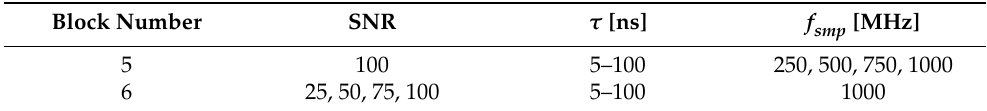
Table 3. Parameters of pulses generated during trials.